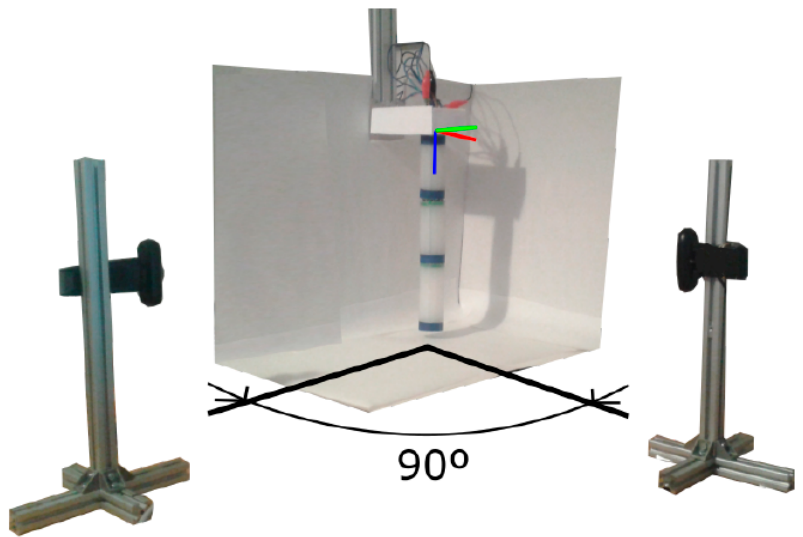
Figure 8. Vision system con fi guration. Source: authors.